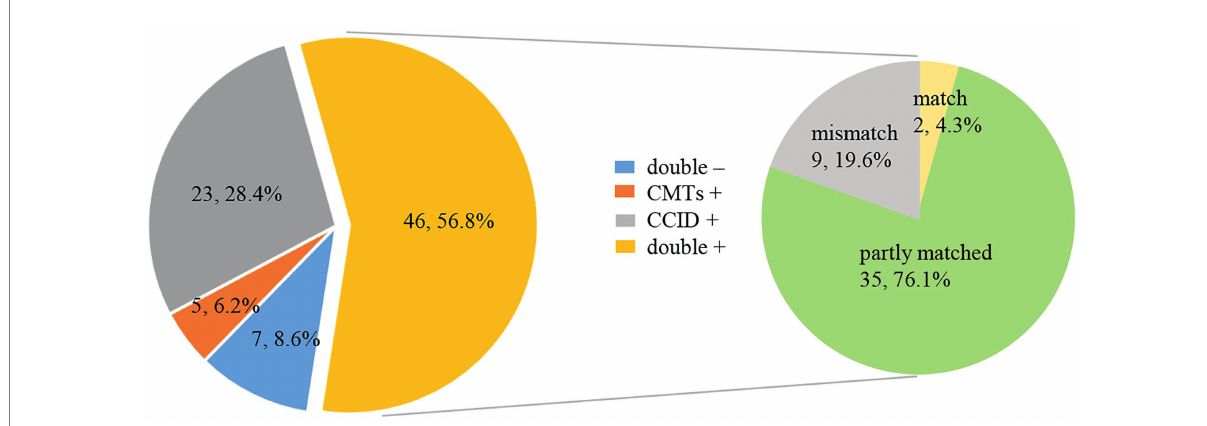
FIGURE 4 Pie chart demonstrating the positivity distribution and concordance between Chips for Complicated Infection Detection (CCID) and conventional microbiological tests (CMTs) for pneumonia in older people ( n = 81). For the double-positive subset, a high proportion of partial matching (35/46) (at least 1 pathogen identified in the test was confirmed by the other) and complete matching (2/46) is seen, with only 9 conflicts between CCID and CMTs